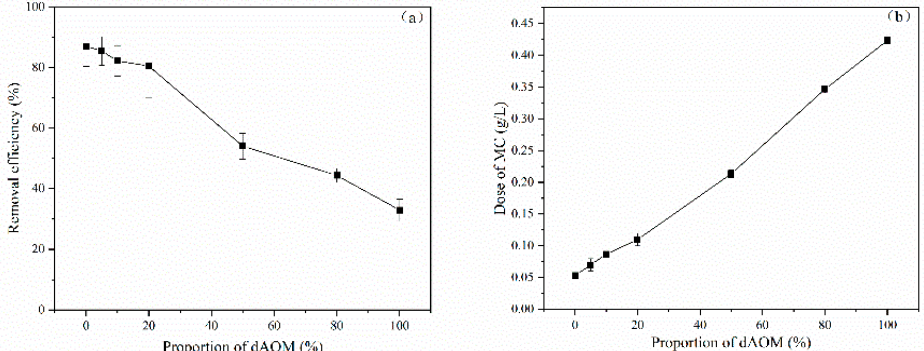
Figure 4. Removal efficiency of MC after three hours under different concentrations of dAOM ( a ), dosage of MC under different concentrations of dAOM at the same algal removal efficiency (80 ± 3%) ( b ).